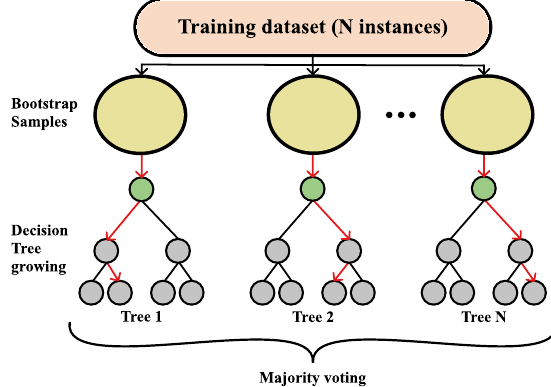
Figure 3. Visualization of the Random Forest classification